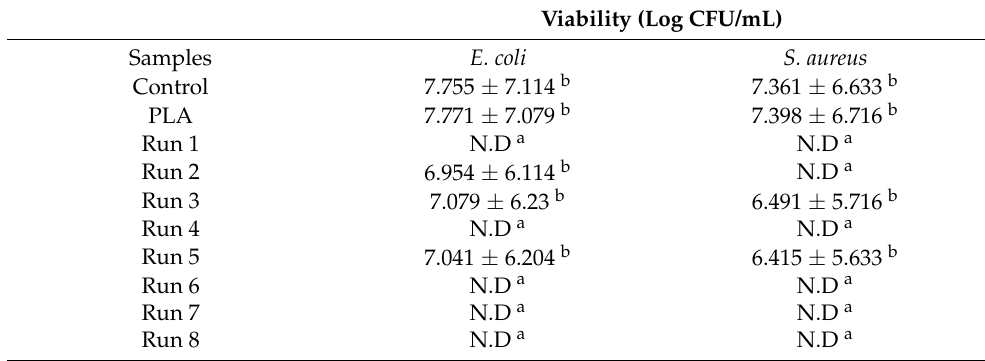
Table 5. Antibacterial activity of Z. multiflora EO extract against E. coli and S. aureus .